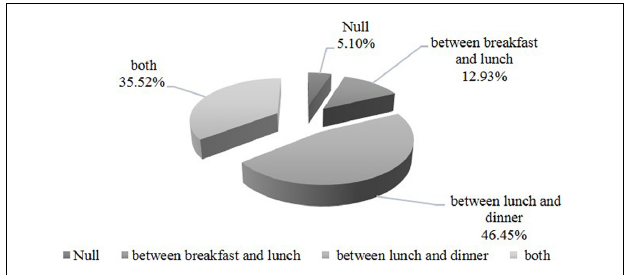
FIGURE 5 | The consumers’ options regarding the consumption of snacks and the moment of having it.